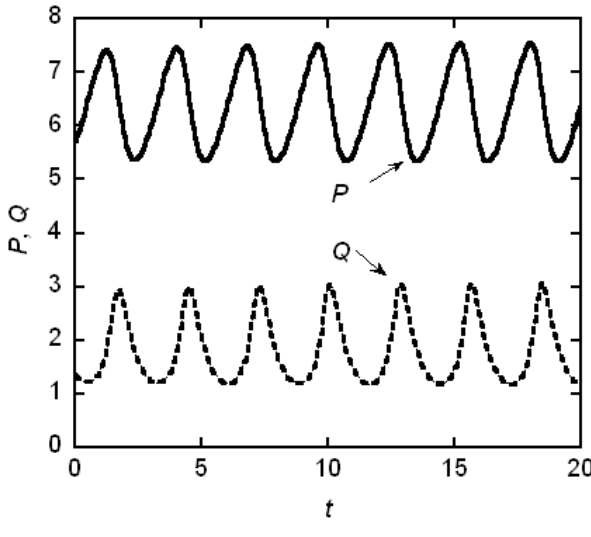
Fig. 6. Limit cycle P(t) , Q(t) for the MBG model with β =5.5 and for values of the time scale ¯ t and ε that minimize the relative error e (Table 2). The origin of the time axis is arbitrary as the transients are not